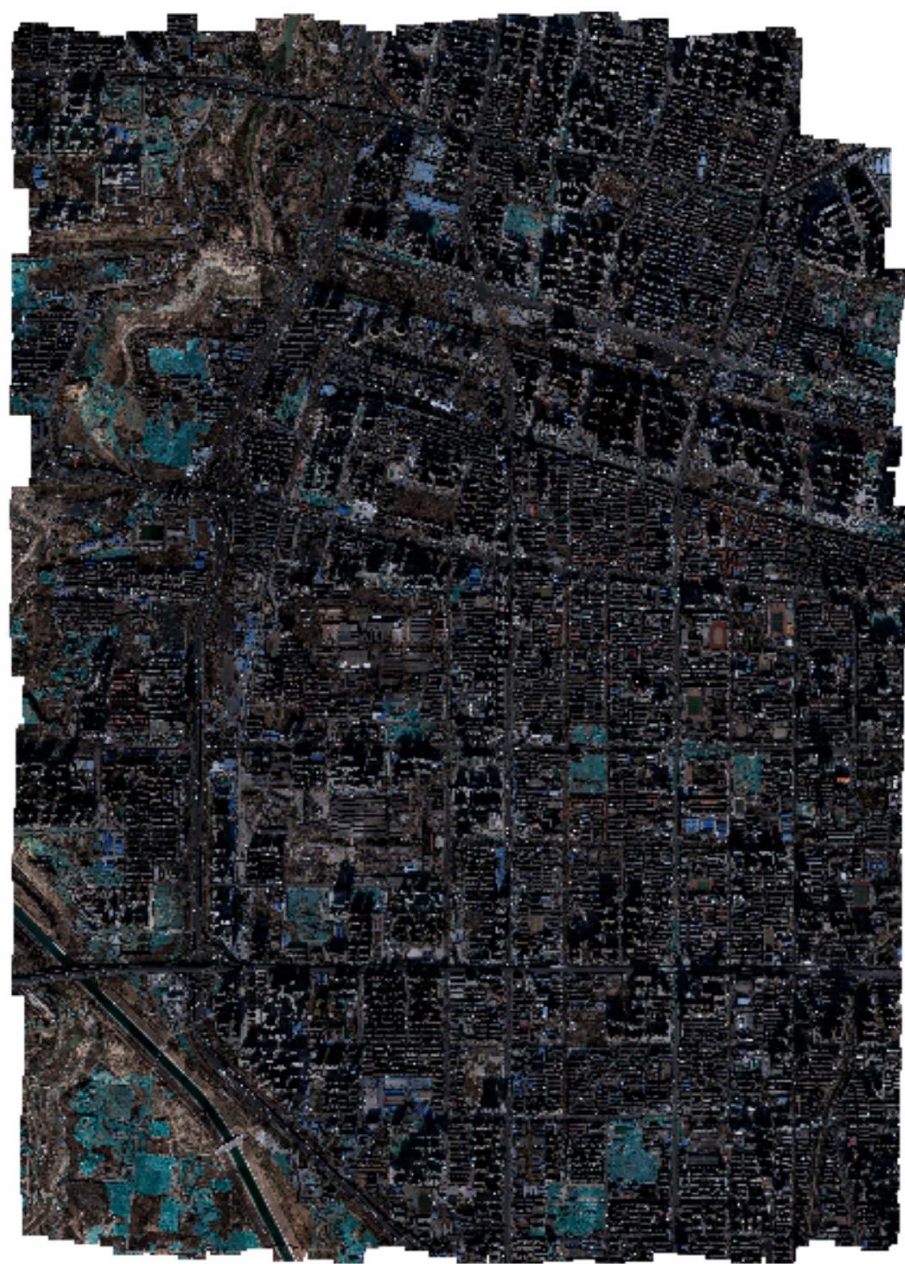
Figure 17. DOM Product After Positioning and Calibration. LightSpeed software was then used for the given dataset, implementing the entire photogrammetry procedure and generating the DOM and DEM products. The photogram- metry results and the DOM and DEM products obtained using the two methods were compared and evaluated. The BA results and the DOM and DEM products obtained by the two approaches were at the same accuracy level, which suggests that our proposed method reaches the precision level of professional photogrammetry